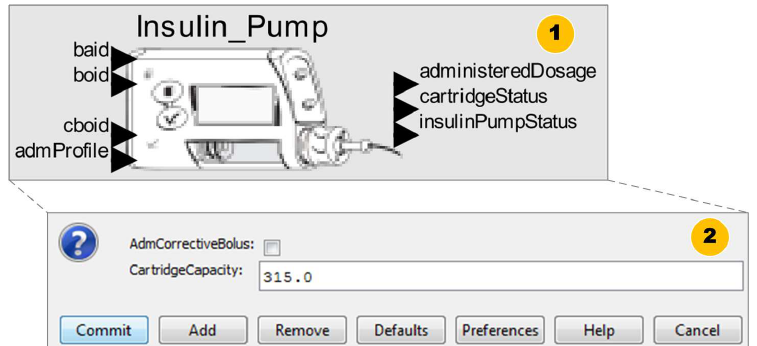
Figure 8. Insulin Pump